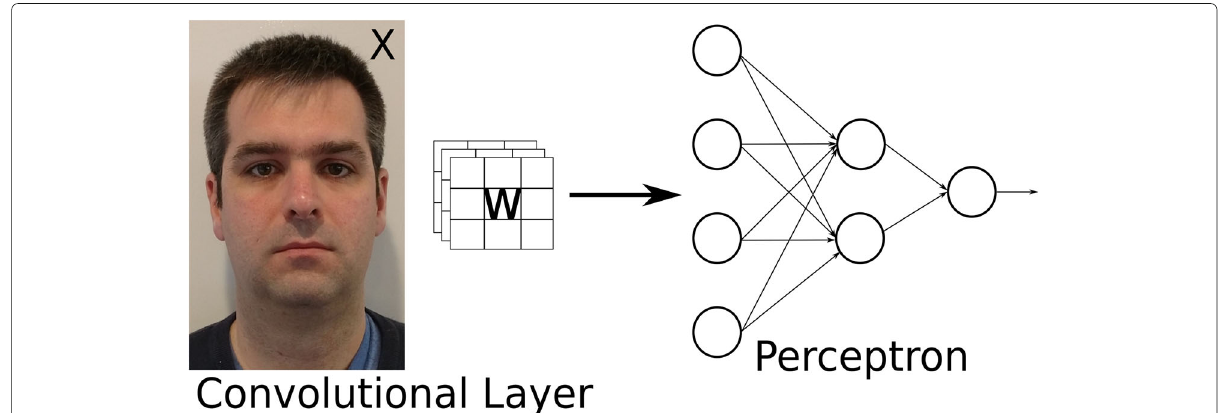
Fig. 6 Simple convolutional neural network. Diagram of a simple convolutional neural network architecture